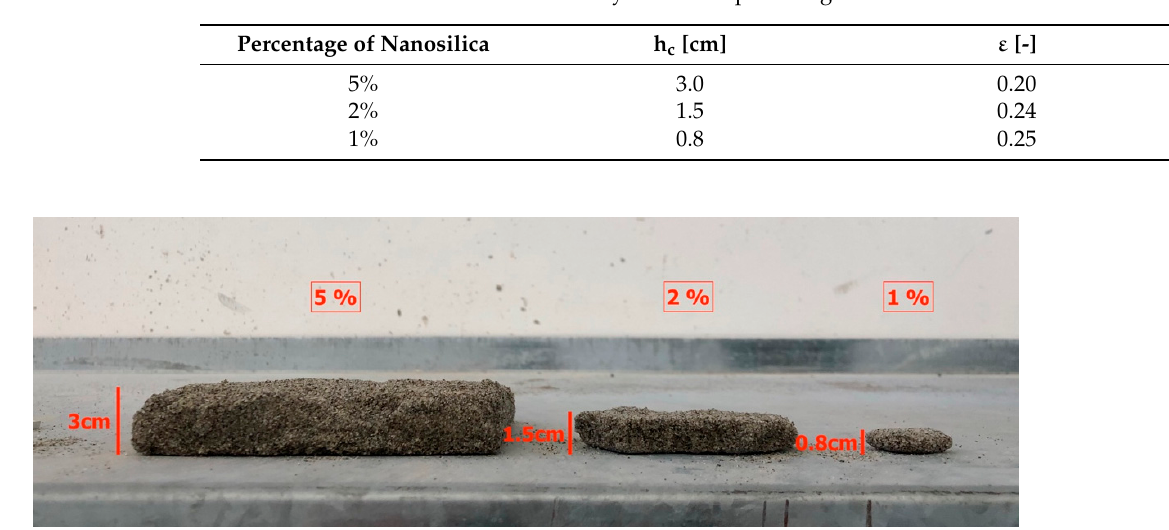
Figure 3. Samples of consolidated layers for different percentages of nanosilica: 5%, 2%, and 1%.